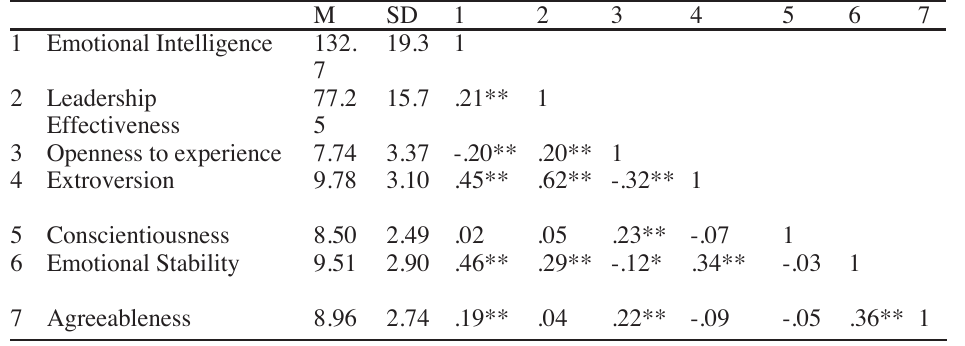
Table 1: Mean, SD, & Correlations Matrix for the Scores on Emotional Intelligence,